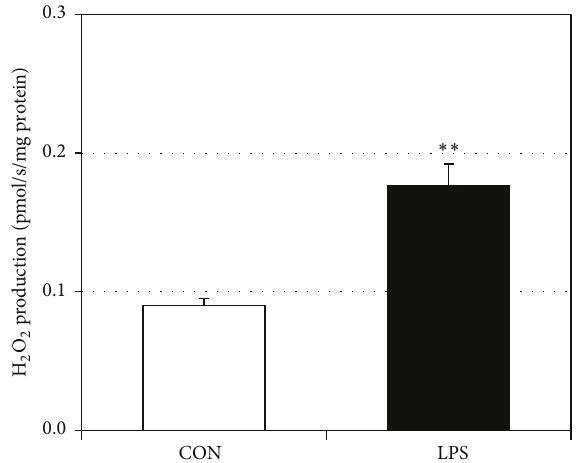
Figure 4: LPS increases H 2 O 2 production in HGF-1 cells. To deter- mine H 2 O 2 production following LPS treatment ((a), 5 𝜇 g/mL for 48 h), Amplex UltraRed fluorescence (530/590 nM) was determined during respiration after calibration with H 2 O 2 (0.1 𝜇 M, 𝑛 = 3 ). ∗∗ 𝑃 < 0.01